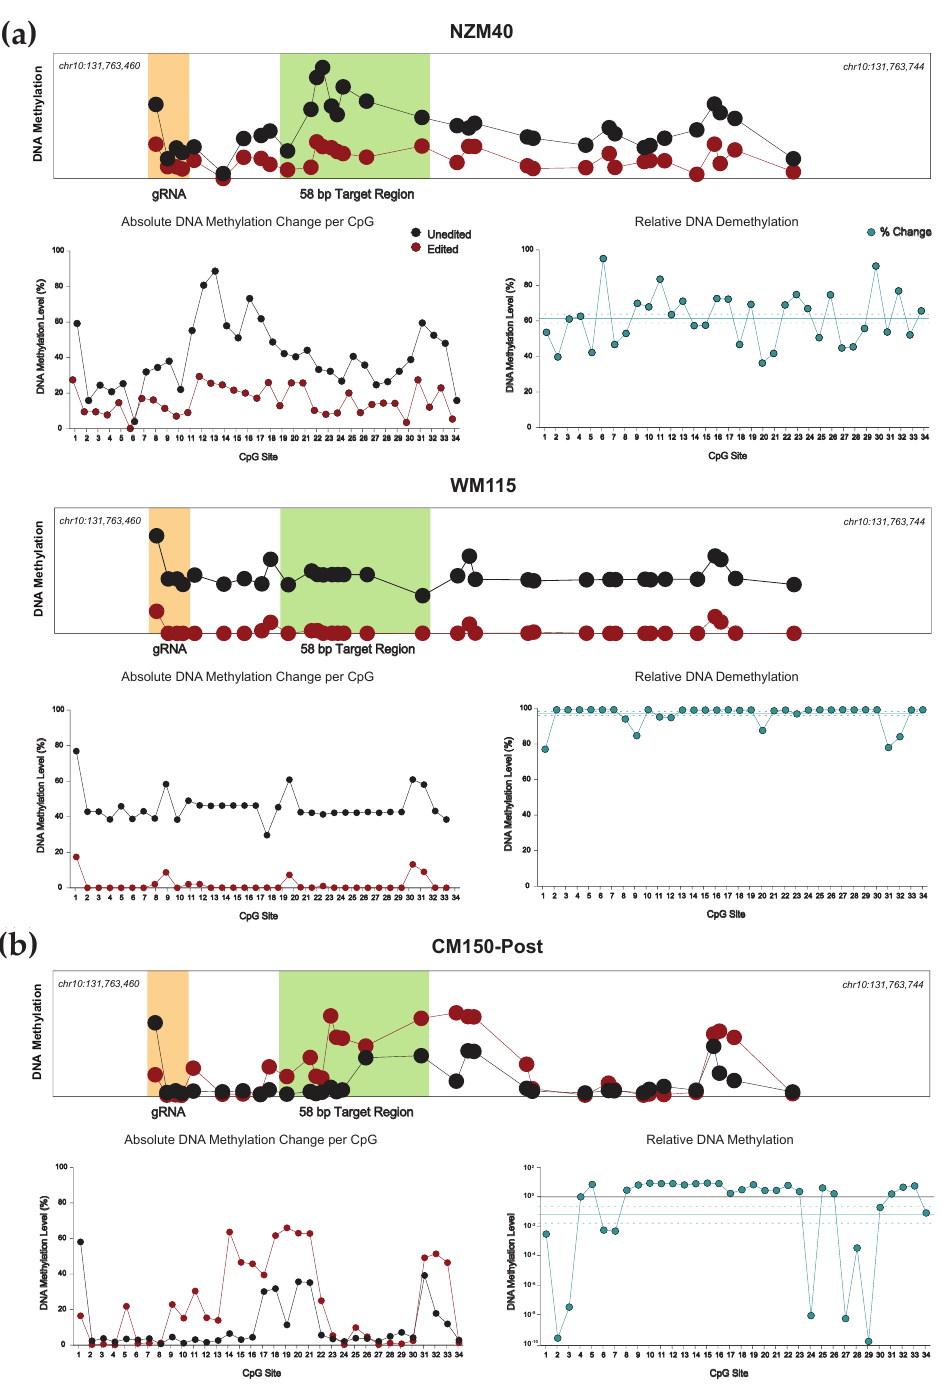
Figure 4. ( a ) Targeted DNA demethylation of the EBF3 promoter region for NZM40 and WM115 cell lines. Mean DNA methylation levels between unedited (black) and edited (red) samples are